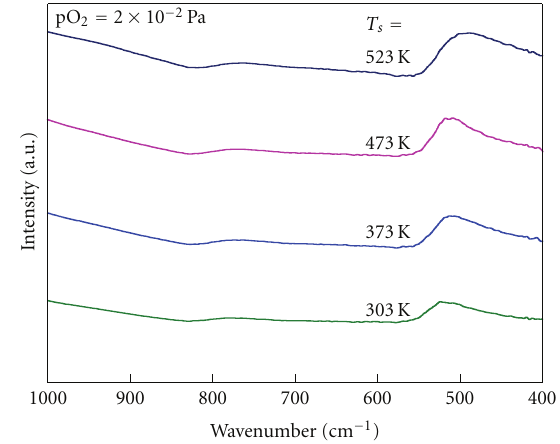
Figure 4: Fourier transform infrared absorption spectra of Ag-Cu- O films formed at di ff erent substrate